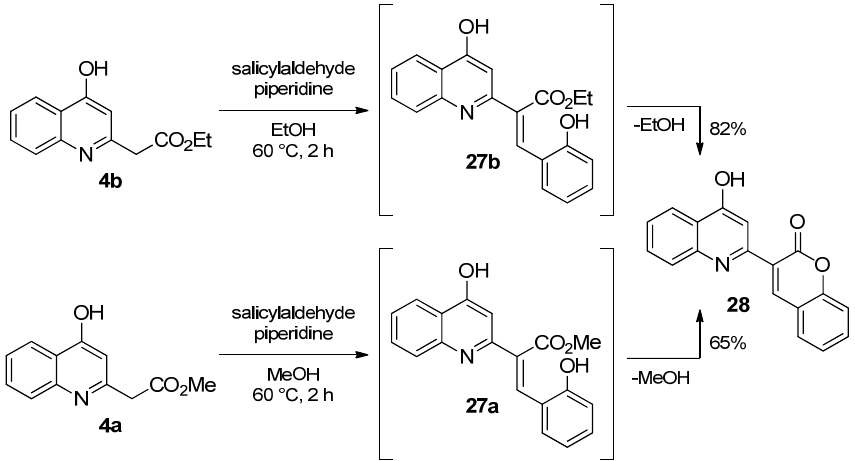
Scheme 5. The reaction of 4 ‐ hydroxyquinolines with aromatic aldehydes in the presence of piperi ‐